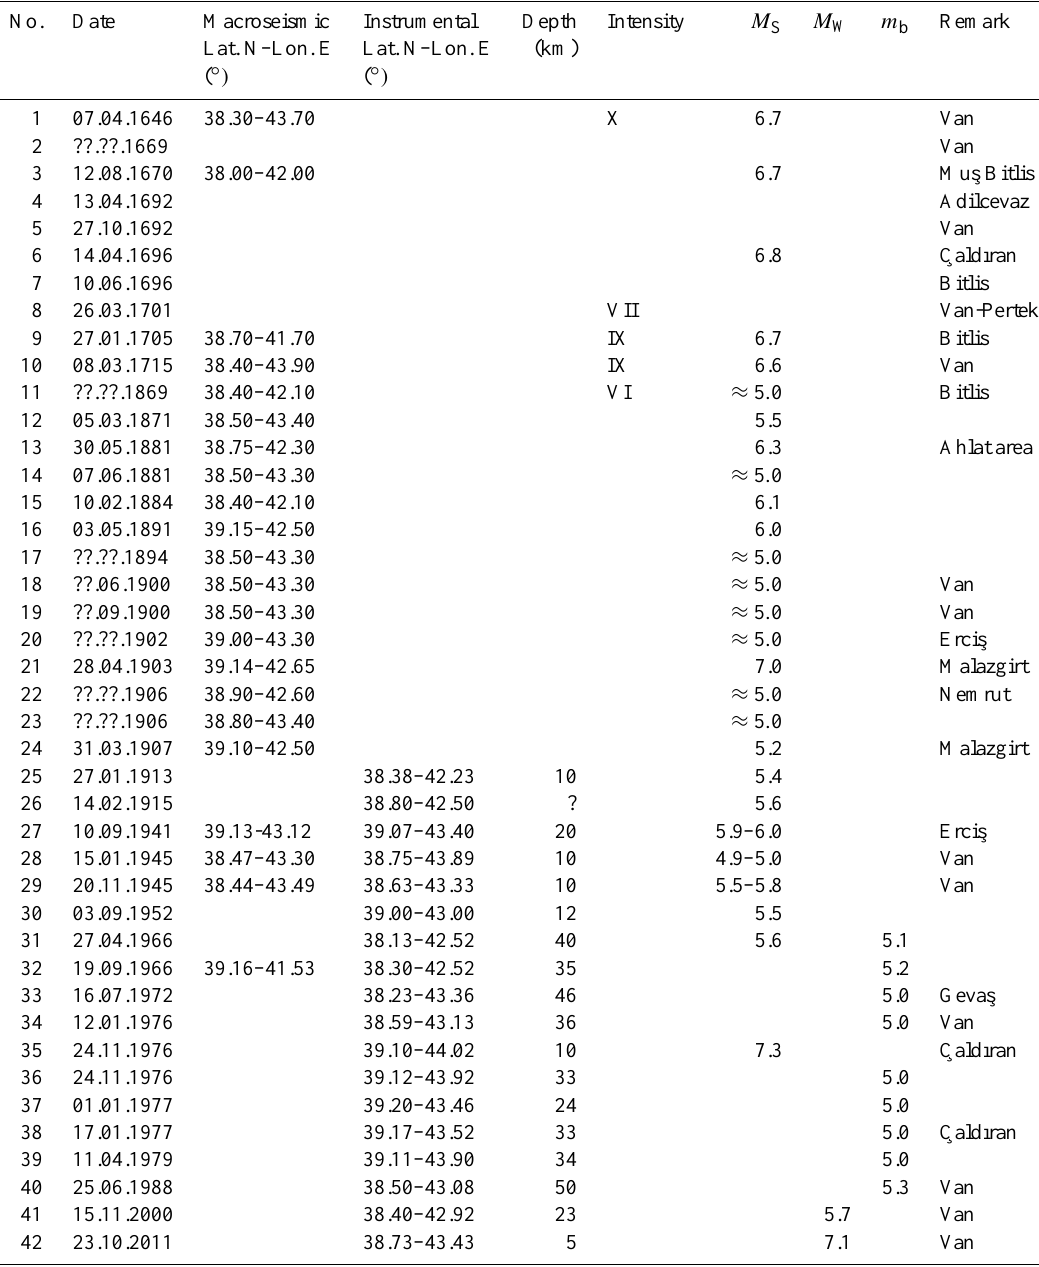
Table 2. The earthquakes of the Lake Van area following 7 April 1646 Van earthquake, compiled from the catalogues given in Sect. 2 of the paper. Only damaging earthquakes are listed until 1860 and the earthquakes with M ≥ 5.0 are listed after that date. See Fig. 2 for the epicentral